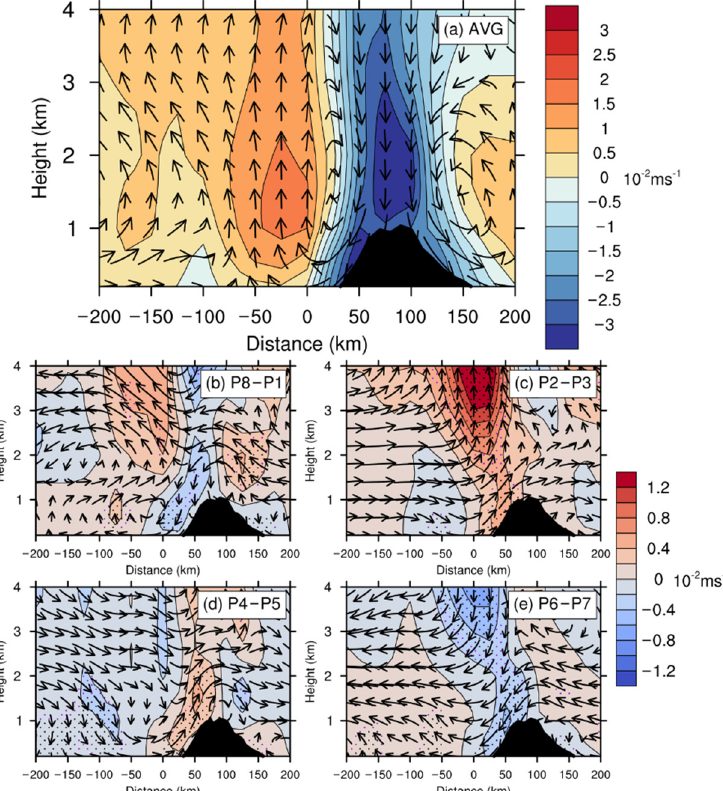
Figure 9. The differences of vertical motion (shaded, 10 − 2 m s − 1 , positive means upward) and wind vectors (the horizontal wind normal to western Sumatra coast with the vertical motion) at 0100 LST from those at 1300 LST ( a ) averaged in DJF 2011–2020 as well as its anomaly in ( b ) P8–P1, ( c ) P2–P3, ( d ) P4–P5 and ( e ) P6–P7. The black shade marks the topography of coastal mountains. The purple and black dots indicate the 90% and 95% confidence according to the Student’s t-test.